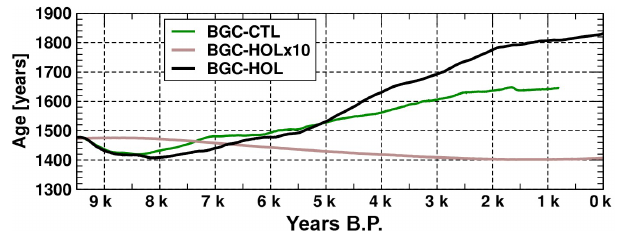
Figure 5. As Fig. 4a, but for the idealized age in years averaged over a volume in the deep North Pacific (150 ◦ E–130 ◦ W, 40–60 ◦ N, 2500–3500m depth).